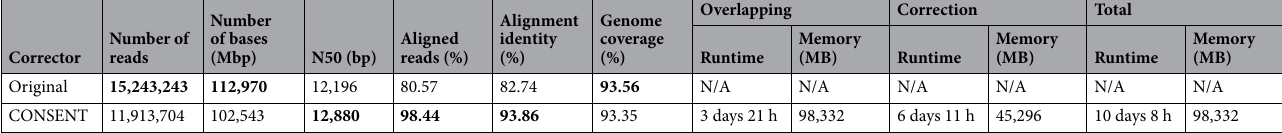
Table 5. Statistics of the full H. sapiens dataset, before and after correction with CONSENT. Best results for each metric is highlighted in